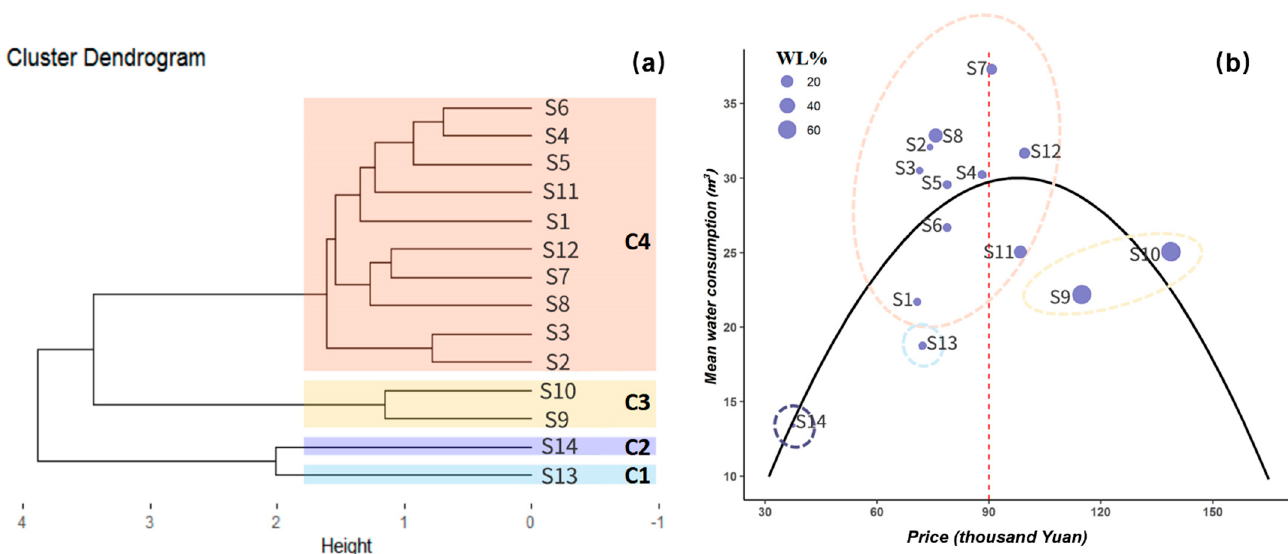
Figure 6. ( a ) The dendrogram of the 14 communities through hierarchical cluster analysis. ( b ) The relationship between price and mean water consumption of the 14 communities. Red line means the average price of the house in the center areas of Shanghai. The significance level of t-test is accepted as the p value was less than 0.05. ( price : house price, WL : the ratio of unoccupied houses on the rental market to the total number of households).